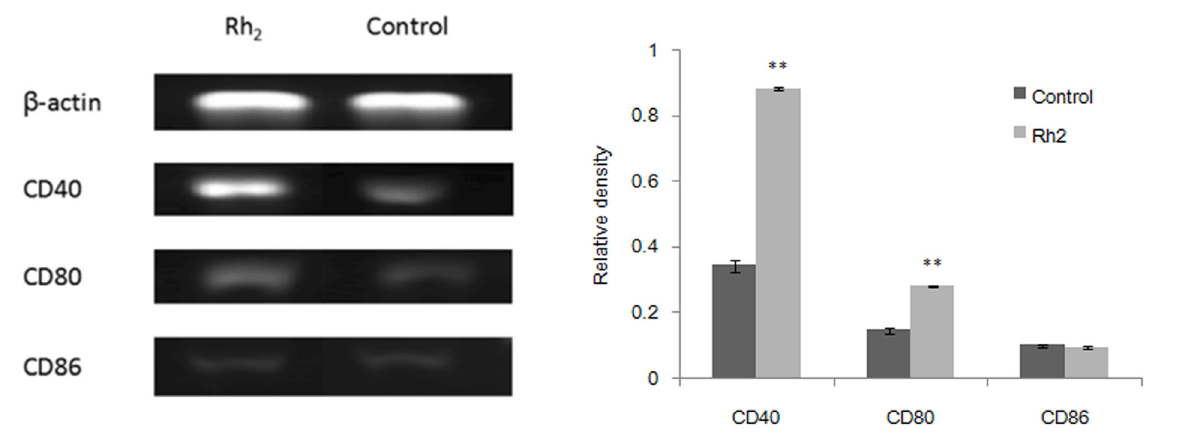
Figure 4: Effects of ginsenoside Rh supernatants of T lymph node cells. (Mean ± SD, N=3), * P<0.05 vs. control; ** P<0.01 vs. control.